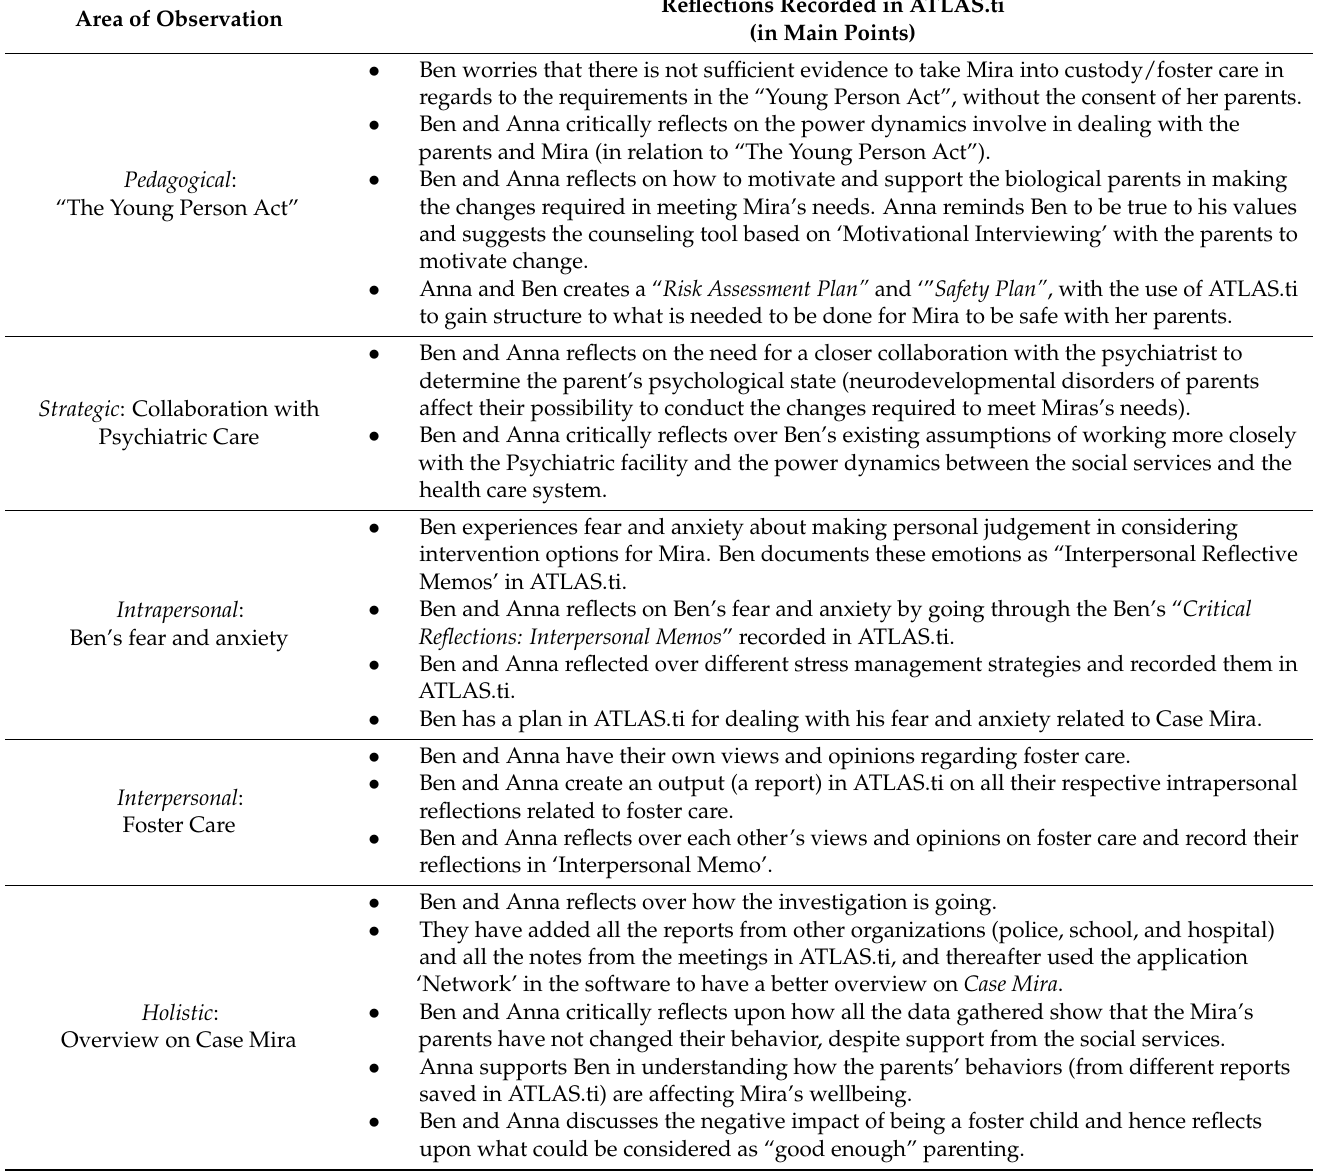
Table 1. Examples on Areas of Observation and Associated Reflections. Reflections Recorded in ATLAS.ti Area of Observation (in Main